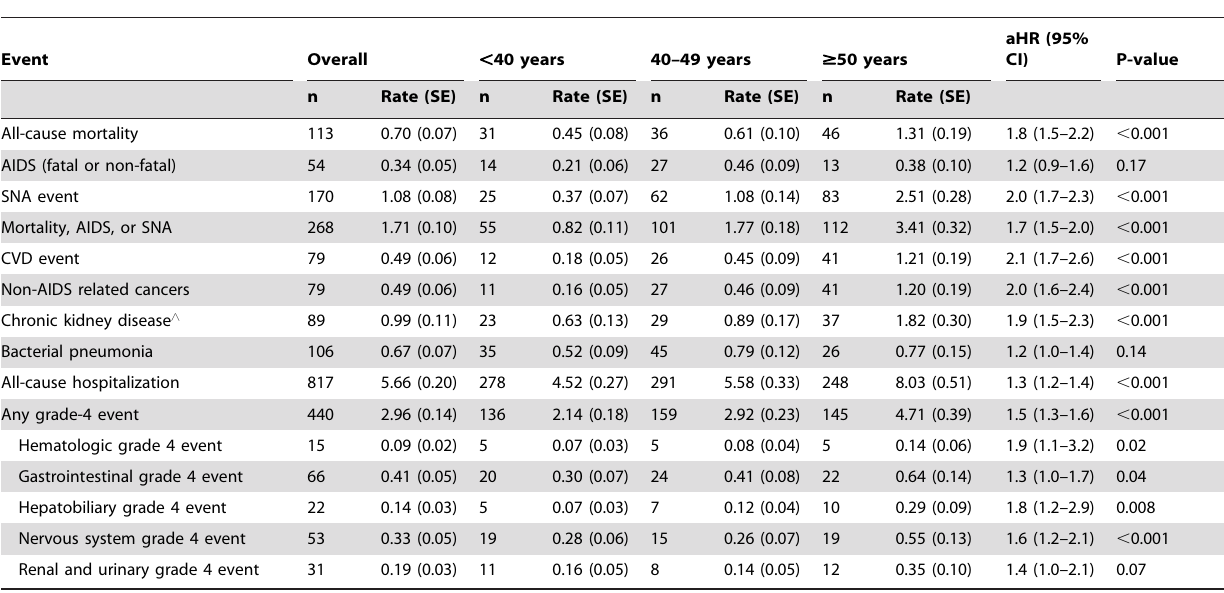
Table 2. Morbidity and mortality event rates by age.